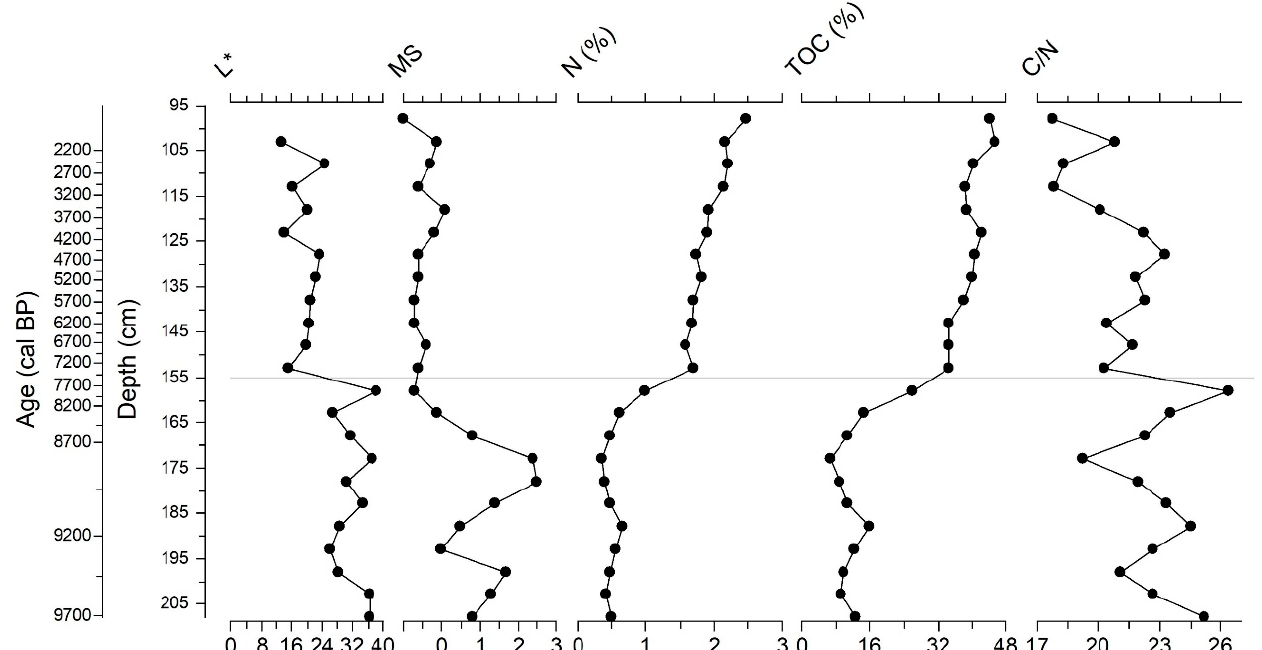
Figure 2 . Down-core variation (dots) in the studied interval (between 95 and 210 cm) of the peat sediment core include sediment lightness (value L*), magnetic susceptibility (MS, SI units ×10 − 6), nitrogen (N%) and total organic carbon (TOC) concentrations, C/N ratio, with age and a horizontal grey line that indicates the transition from clayey sediments to peat (at 155 cm). Table 2. Results of radiocarbon AMS dating of charcoals and seeds from the Blatuša mire (prepared by: N. Piotrowska; modified by: D.